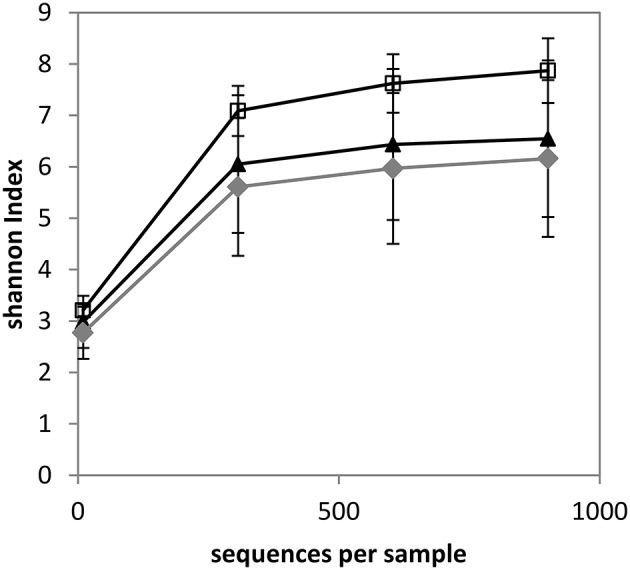
Rarefaction curves of samples with regard to quarter status as determined by the Shannon index. White squares, healthy quarters (Hq); gray diamonds, not determined status (NDq); black triangles, quarters that have already developed mastitis (Mq).